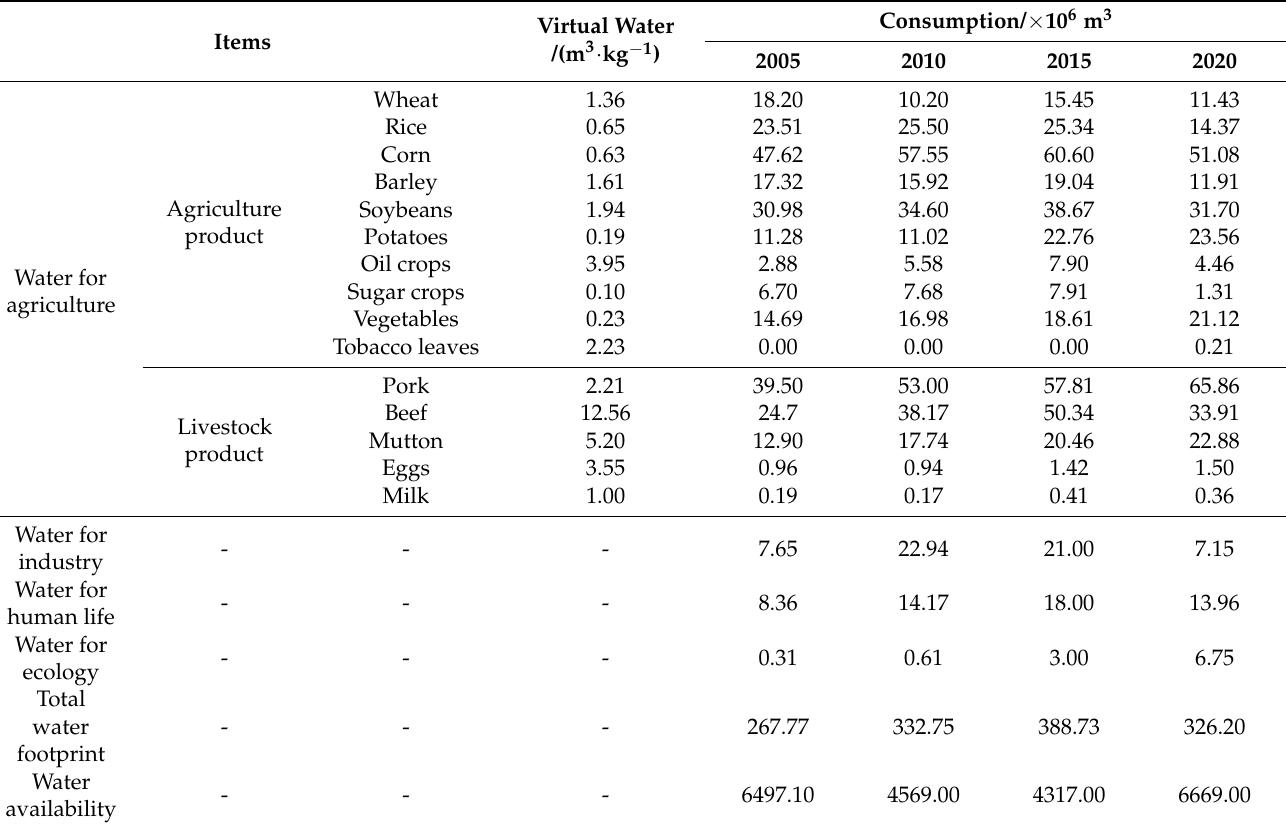
Table 3. Water footprint of Nujiang Prefecture in